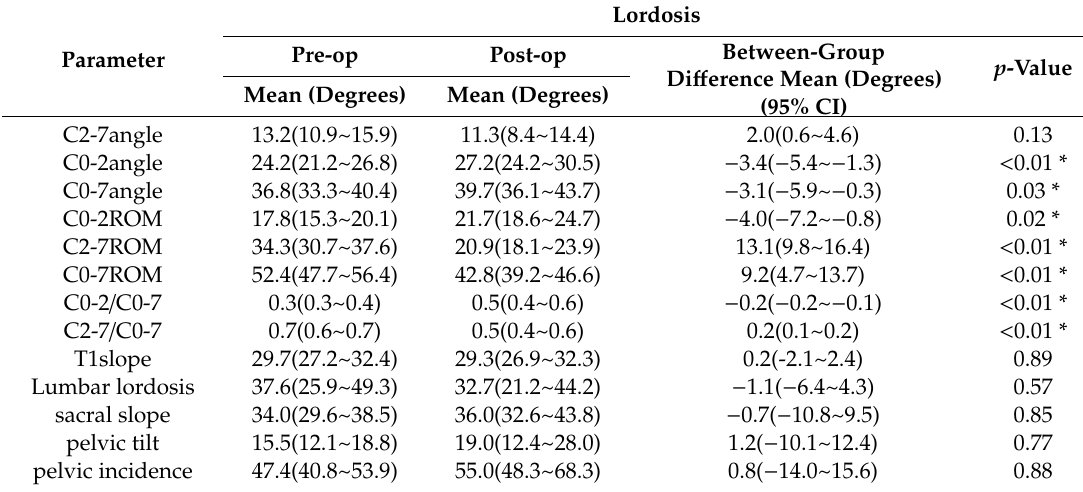
Table 5. Comparison of pre-operative vs. post-operative radiological parameters of lordosis groups.